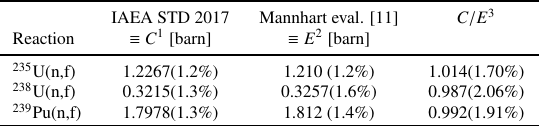
Table 1: Fission SACS calculated C in a 252 Cf(sf) refer- ence neutron spectrum [10] versus measured data E (rep- resented by the Mannhart evaluation [11]), and the corre- sponding C / E with uncertainties.